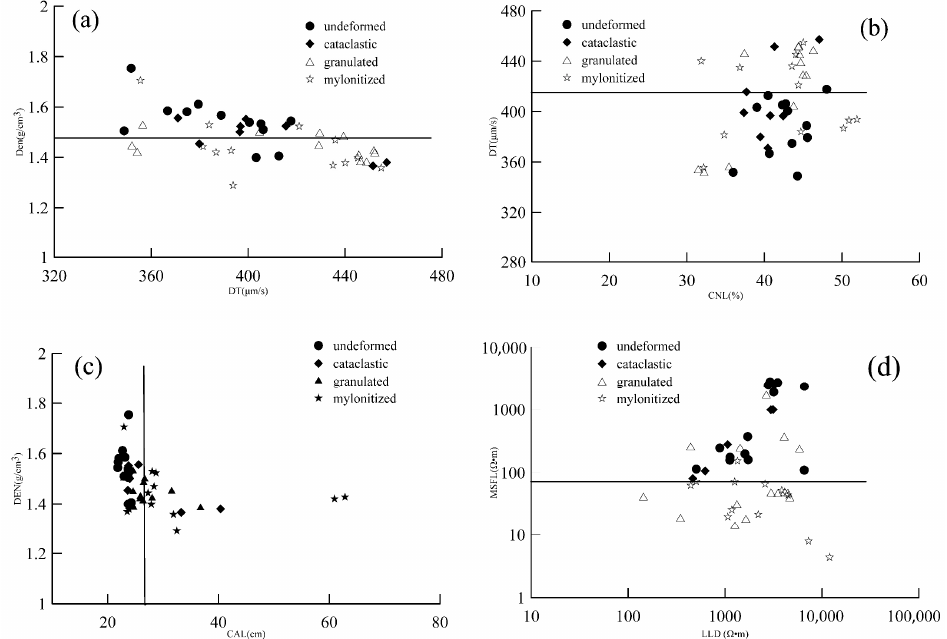
Figure 4. Cross plots between the TDC of the coal core sample from the No. 11 coal seam and its log response. ( a ) bulk density (DEN) and acoustic travel-time (DT); ( b ) DT and compensated neutron log (CNL); ( c ) DEN and hole diameter (CAL); ( d ) deep-laterolog resistivity (LLD) and microspherical focused resistivity (MSFL).